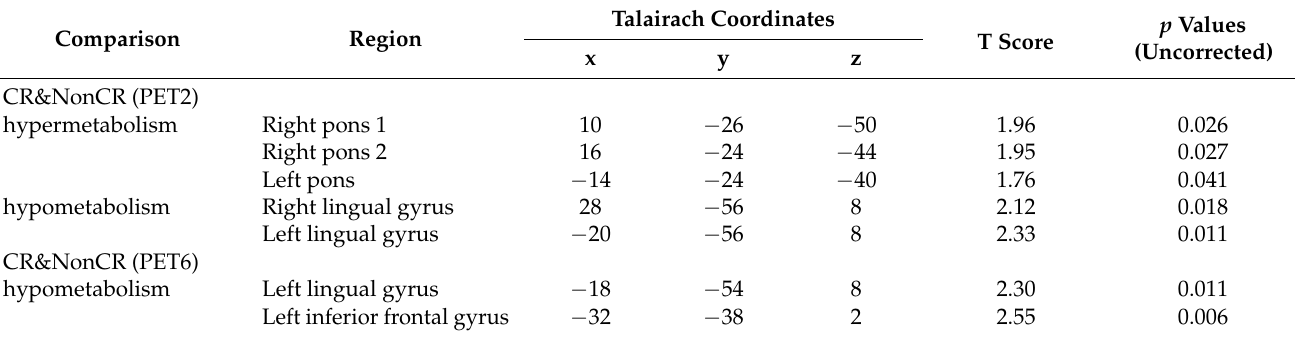
Figure 2. ( A ): Patients with complete responses (CRs) exhibited hypermetabolism on both sides of the pons (red) and hypometabolism on both sides of the lingual gyrus (blue) compared with the findings in the NonCR group (partial responses and progressive disease) in the PET2 scan. ( B ): The CR group displayed only hypometabolism in the left lingual gyrus and inferior frontal gyrus compared with the findings in the NonCR group in the PET6 scan. Table 2. Brain areas with significantly different glucose metabolism between the complete response (CR) and NonCR (progressive disease and partial response) groups in the PET2 and PET6